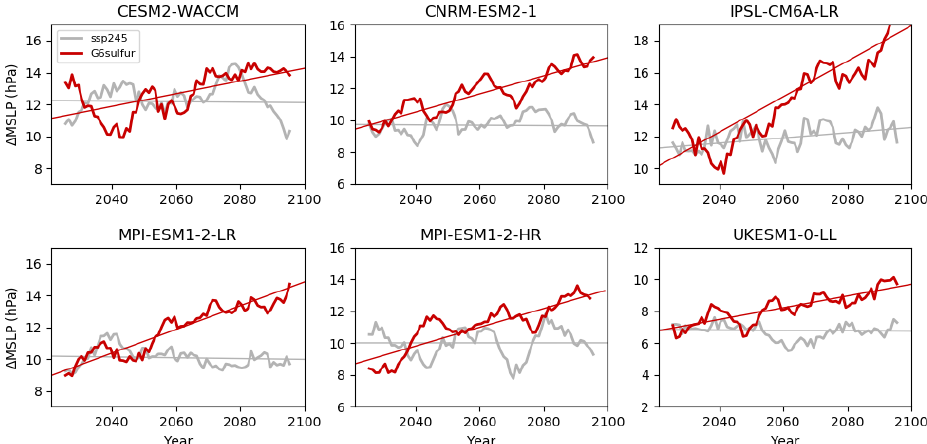
Figure 2. Evolution of the North Atlantic Oscillation, defined as the December to February mean sea-level pressure difference between regions bounded by 90 ◦ W–60 ◦ E, 20–55 ◦ N and 90 ◦ W–60 ◦ E, 55–90 ◦ N (hPa), for each model in experiments ssp245 (grey) and G6sulfur (red). All results are ensemble means and have been smoothed using a 10-year running mean; a least-squares straight line fit to each is also plotted.